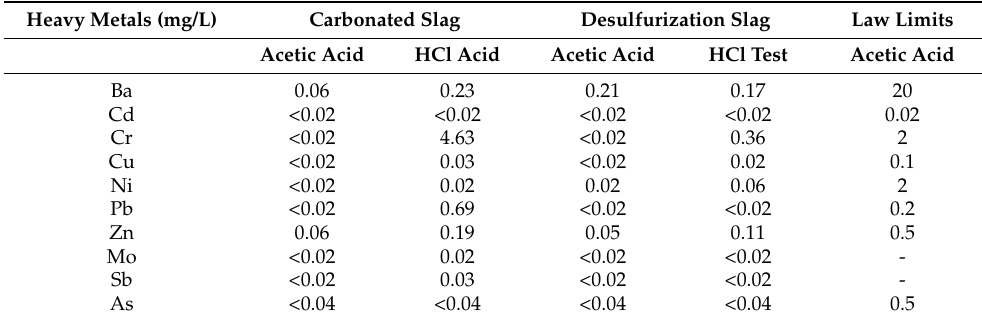
Table 5. Heavy metals (mg/L) in c-BOF and De-S slags’ eluates in acetic acid solution 0.5 N and in HCl solution 1:20 (the error associated with the measure e is 30%).